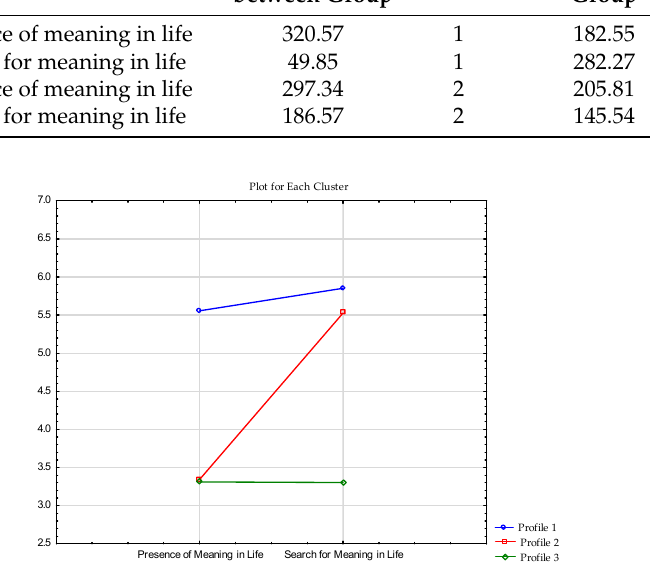
Figure 2. Clusters of MLQ scale in the sample of respondents. Cluster analysis revealed three clusters. The first cluster contained 114 individuals who had high scores on both scales (i.e., a high score on the presence of meaning in life subscale and a high score on search for meaning in life scale). The second cluster com- prised 91 respondents who scored average on the Presence of meaning in life and scored high on the search for meaning scale. The last cluster was composed of 37 respondents who received averages scores on both scales (see Figure 2). 3.3. Positive and Negative Affect in the Group of Mountain Hikers Another step included the analysis of profiles for PANAS scale (positive and negative affect). The results are presented in Table 3 and Figure 3. Table 3. Variance within and between groups for PANAS scale: results of k-means cluster analysis.